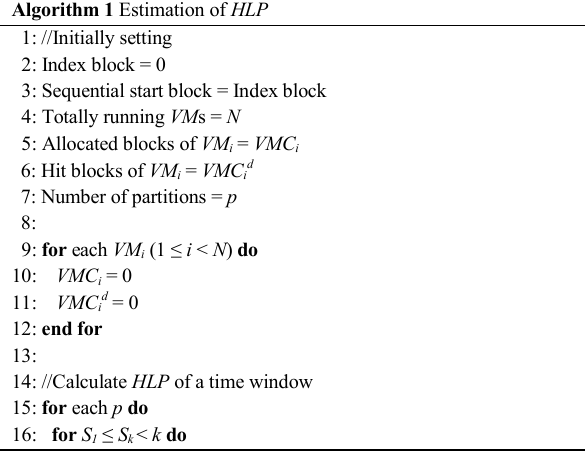
Algorithm 1 Estimation of HLP